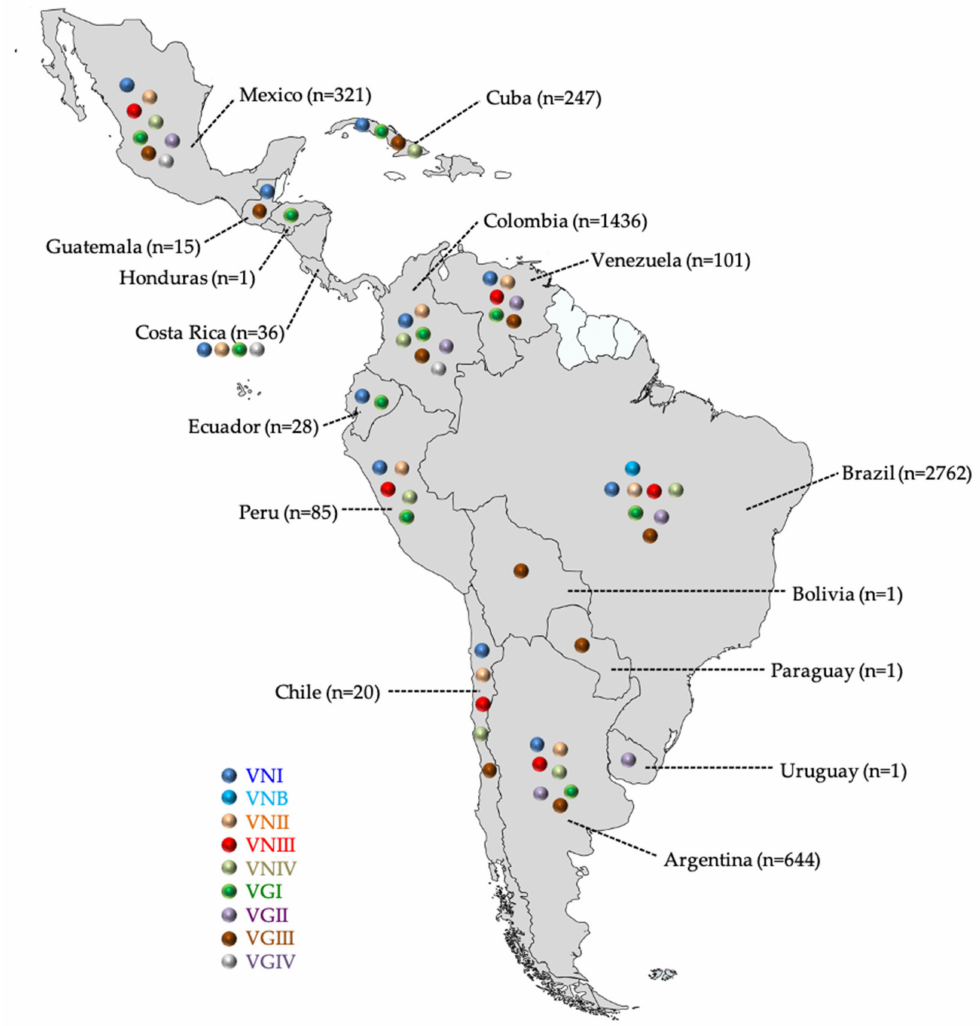
Figure 1. Geographic distribution of the molecular types of Cryptococcus neoformans and Cryptococcus gattii species com- plexes in Latin